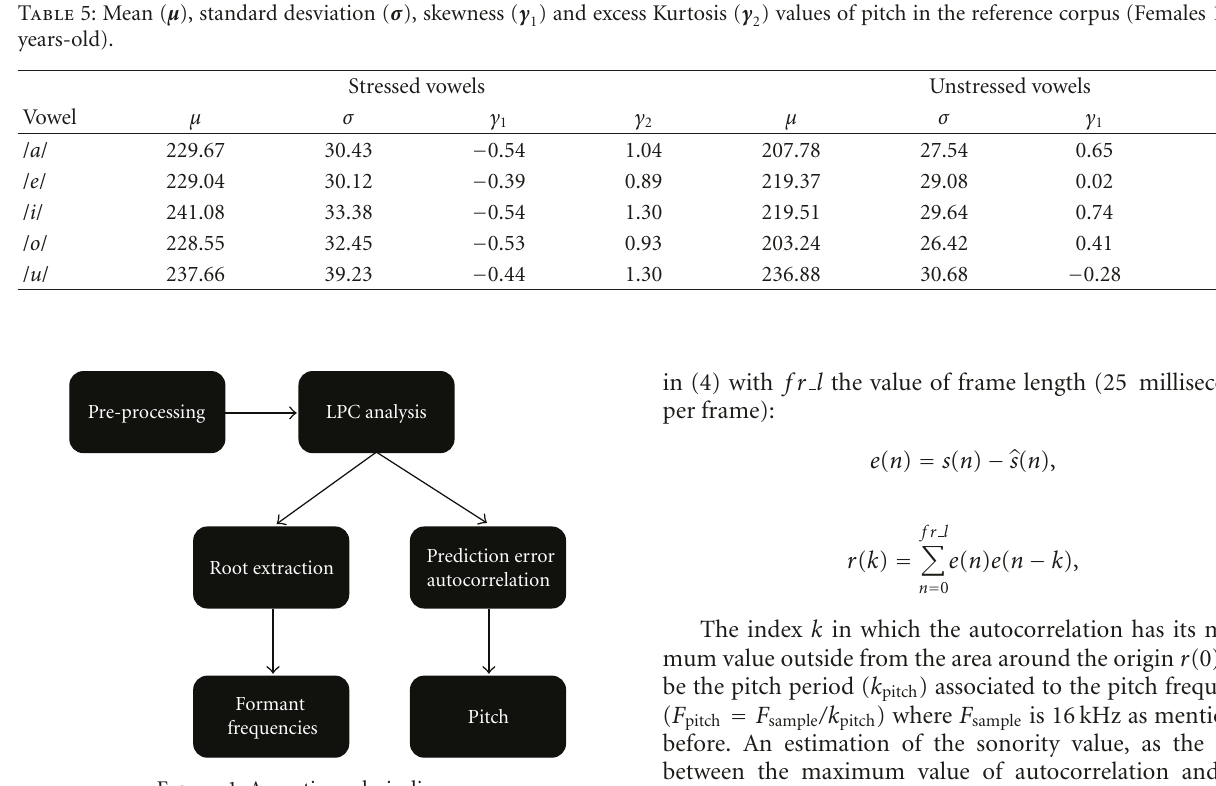
) and excess Kurtosis ( γ ) values for the first and second formants in the reference 1 2